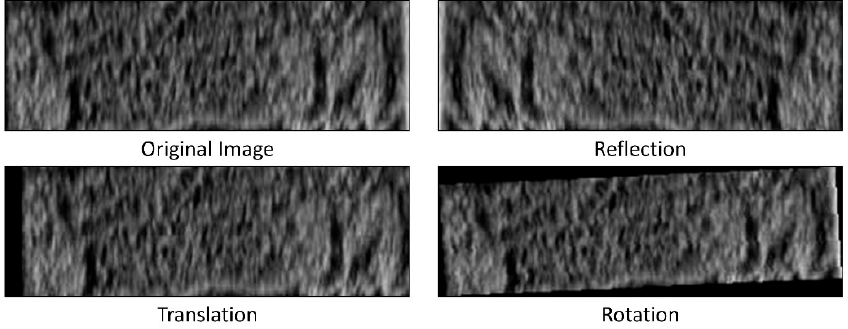
Figure 8. Original UAS image and three augmented images generated by geometric transformations.